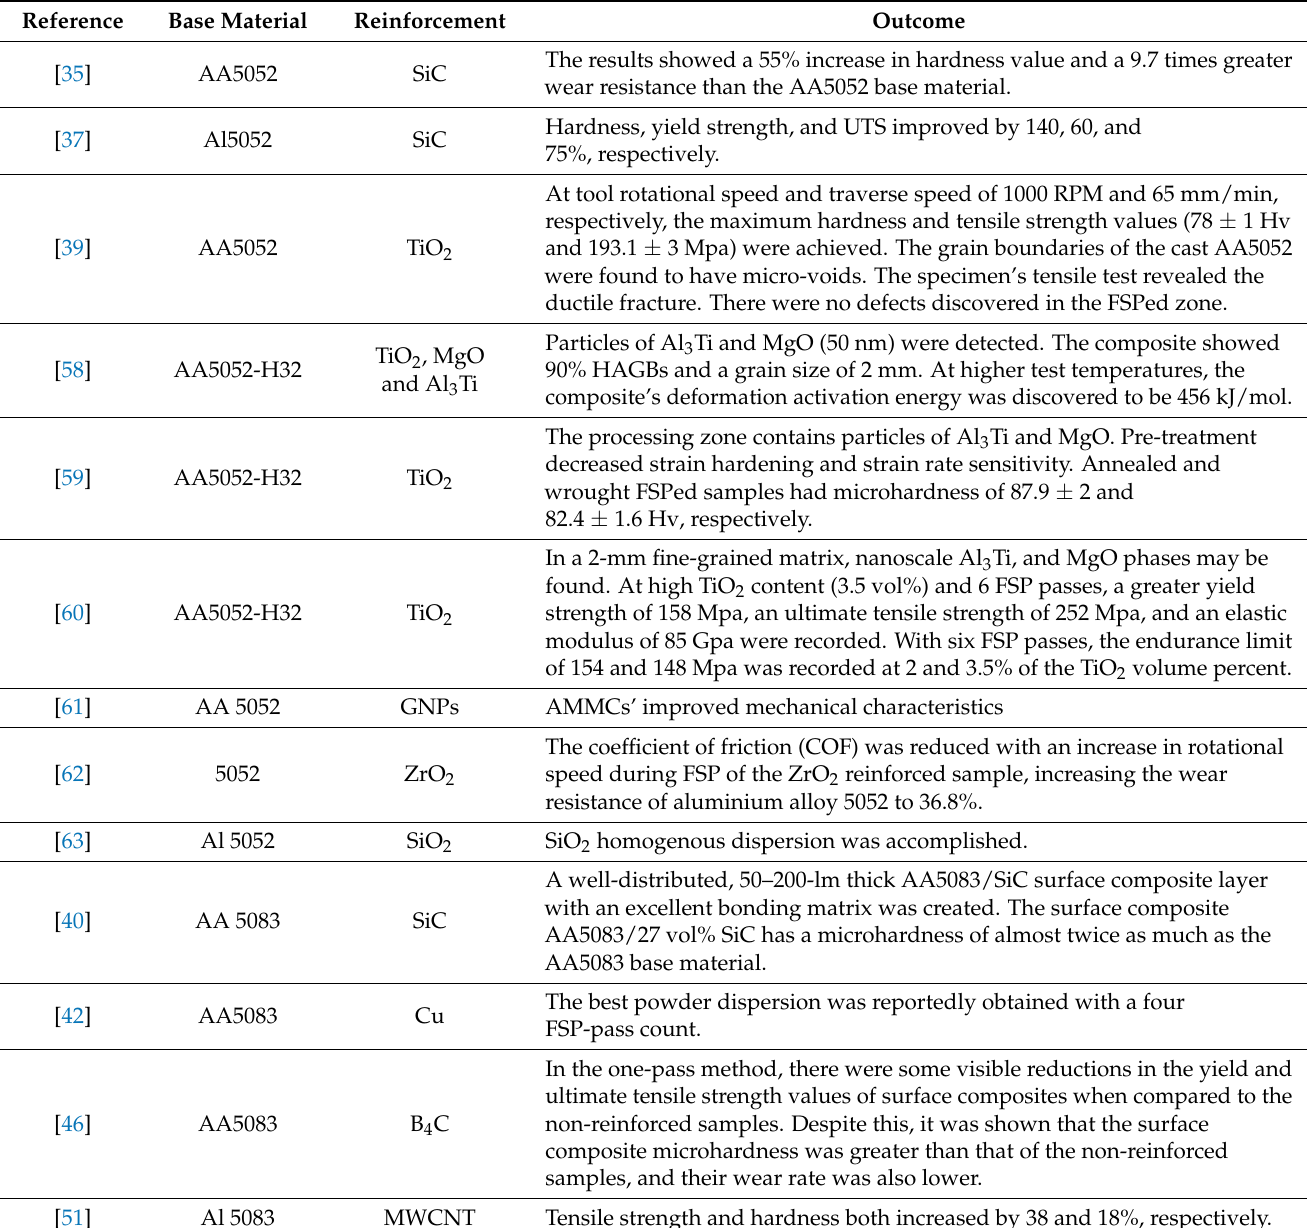
Table 1. Aluminium metal matrix composites fabricated from the 5xxx series of aluminium magne- sium alloys using only marine grades reinforced with various reinforcements using the FSP